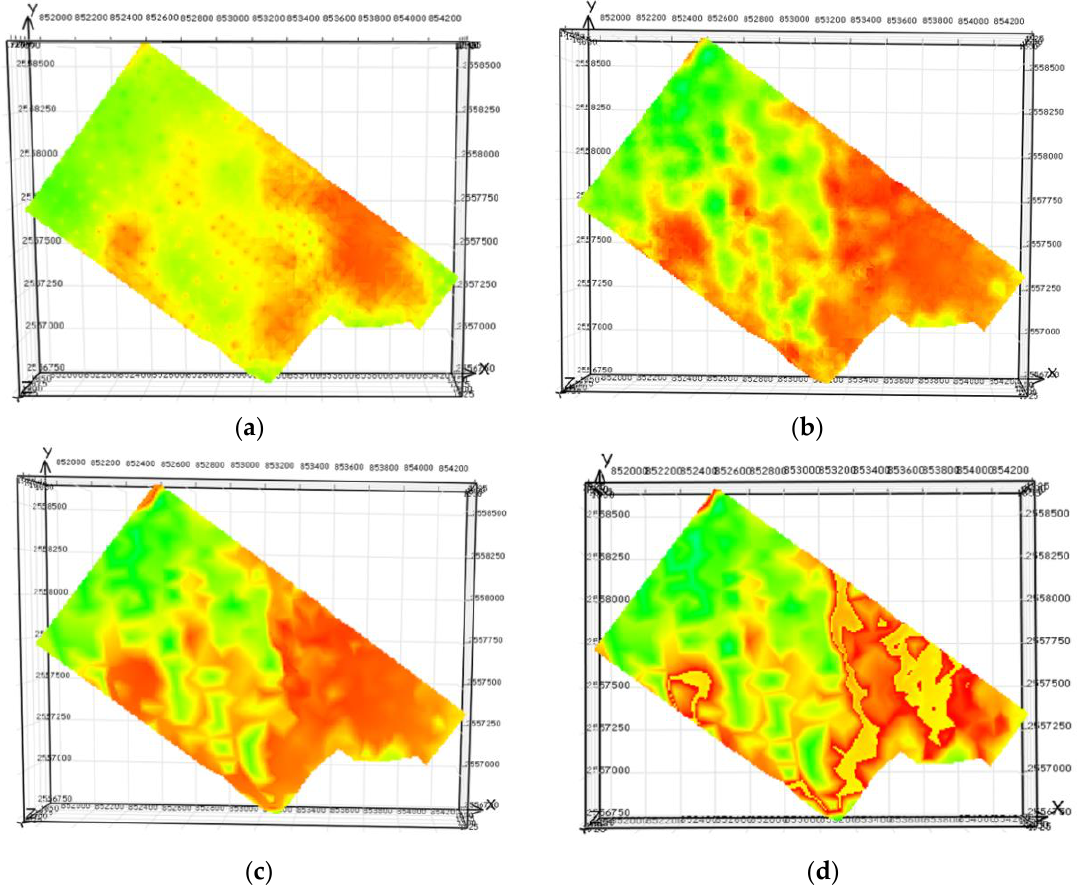
Figure 11. Horizontal property profiles for the four interpolation methods. ( a ) Inverse distance weighting (IDW) interpolation; ( b ) kriging interpolation; ( c ) linear triangular prism interpolation; ( d ) quadric triangular prism interpolation.